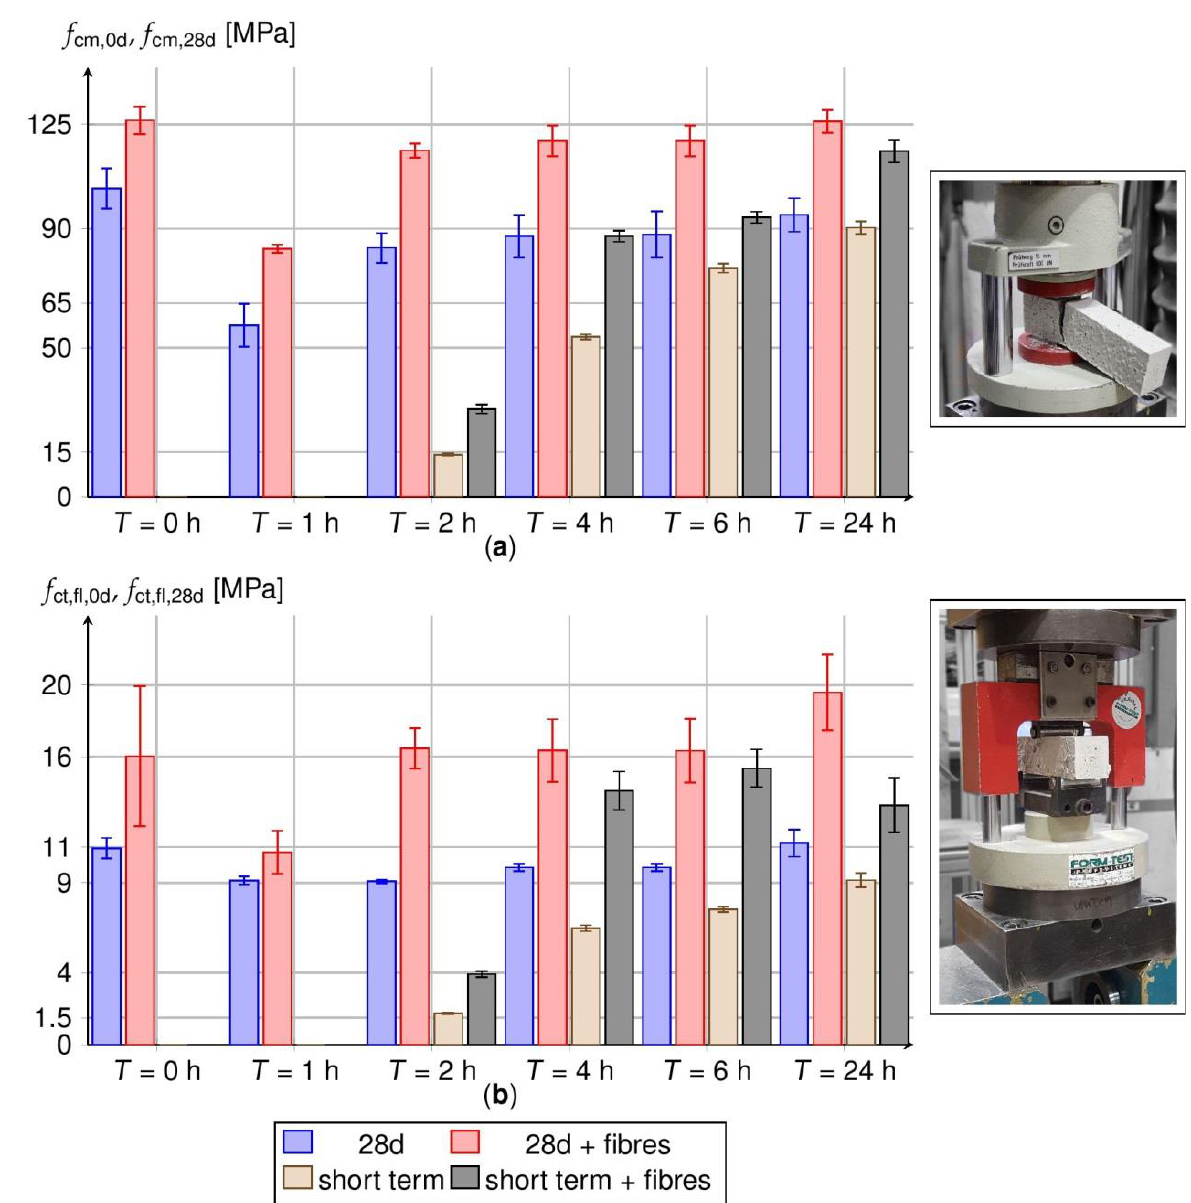
Figure 14. Compressive- ( a ) and flexural strengths ( b ) of the prisms at t = 28 d (reference, red and blue columns) and directly after the heat treatment (brown and grey columns).